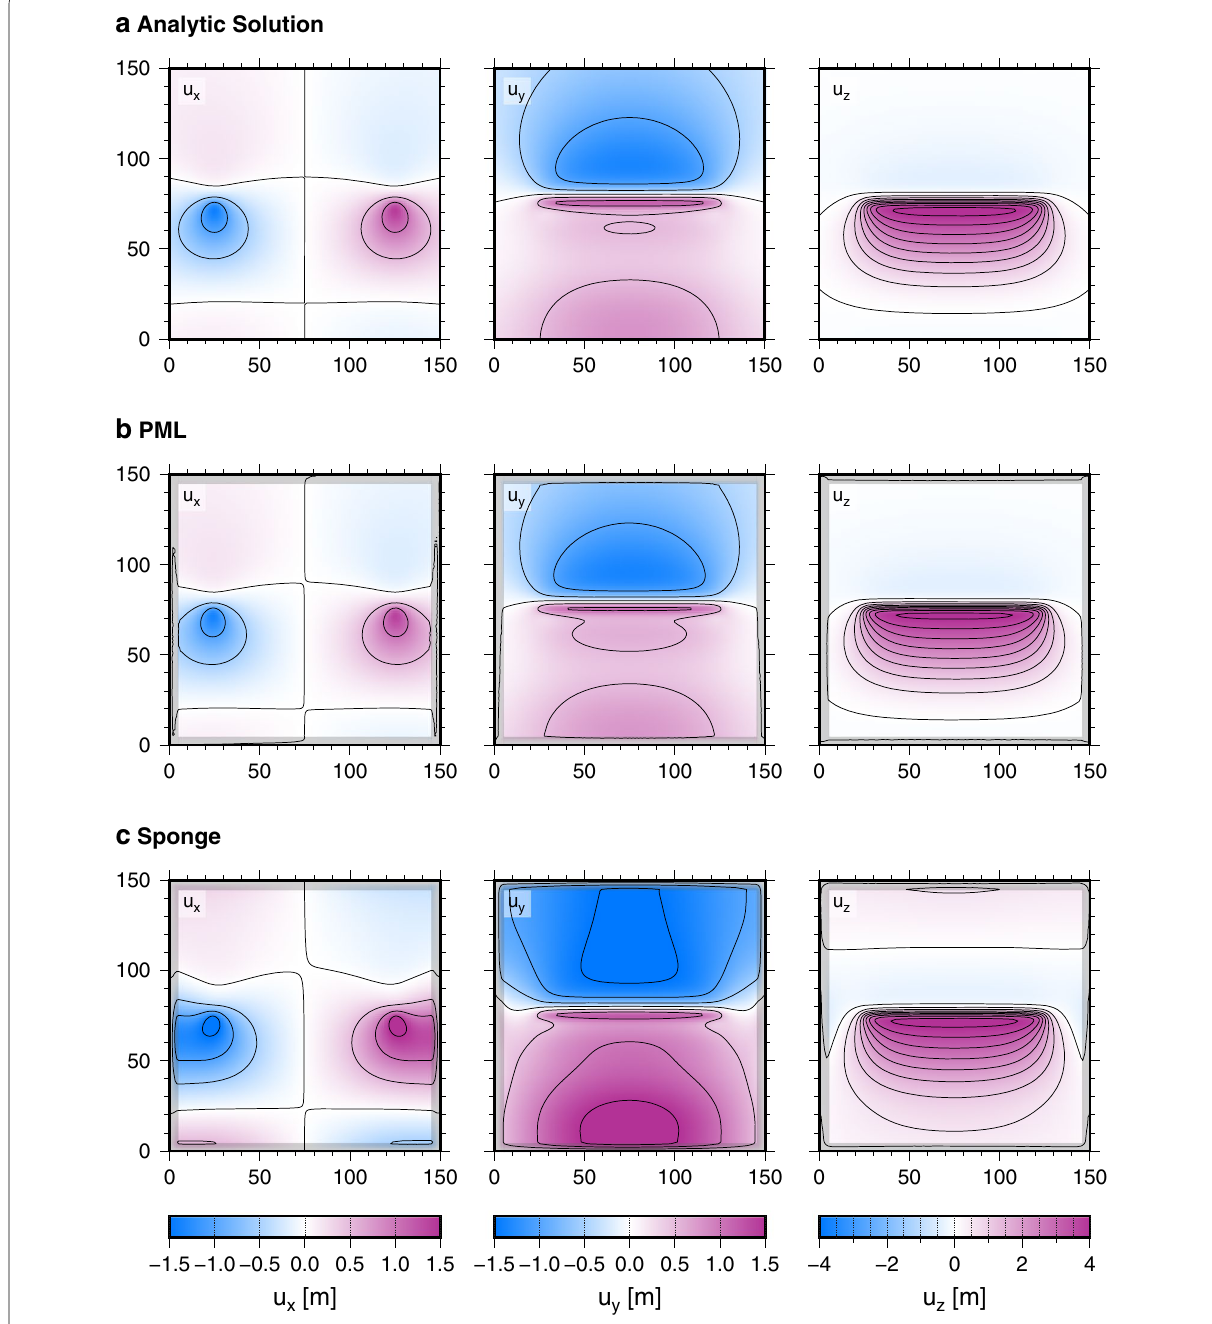
Fig. 14 Comparison of the coseismic deformation of a an analytic solution of Okada (1985), b the result of a simulation by OpenSWPC with the PML boundary condition and c the result of a simulation by OpenSWPC with the sponge boundary condition of Cerjan et al. (1985). In each panel, three-component displacements ( u x , u y , and u z ) are plotted with the color scales shown below. The gray shaded areas in b and c indicate the absorber regions. Time-sequential movies corresponding to b and c are provided in Additional file 2, Additional file 3,